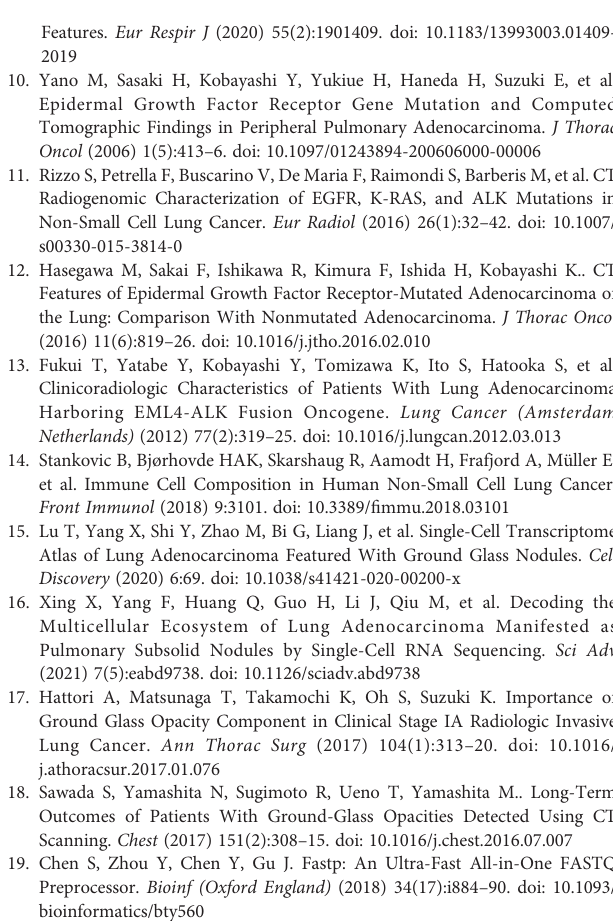
of CD8+ T cells and B cells. Supplementary Figure 3 | (A) The bubble plot shows upregulated signaling pathway of cancer cells in S component. KEGG pathway is on the left plot and Reactome pathway is on the right plot; (B) The bubble plot shows upregulated signaling pathway of cancer cells in GG component. KEGG pathway is on the left plot and Reactome pathway is on the right plot; (C) The single-cell entropy analysis reveals a slightly higher stemness of cancer cells in S components versus GG component. Supplementary Figure 4 | (A) The bubble plot shows signi fi cantly enriched KES Reactome pathways in Mac3, Mac6, Mac4, Mac5, respectively. The colors of bubbles represent the values of signi fi cance and the sizes represent the number of genes enriched in the pathway; (B) The bubble plot shows signi fi cantly enriched KEGG (left) and Reactome (right) pathways in Mac1; (C) Average expression of SPP1 in macrophage subclusters; (D) IFA shows enrichment of SPP hi macrophages in S components (right) in comparison with the GG components (left). Yellow arrows indicate macrophages existing in the S components (right) featured as malignant acinus with upregulation of SPP1 (green). Red arrows indicate macrophages in the GG components (left) with poor expression level of SPP1. Scale bars:50